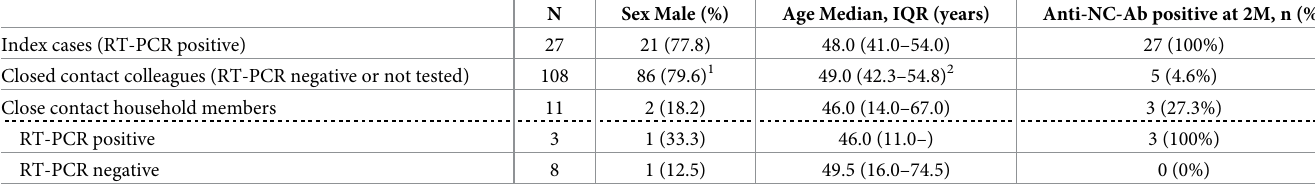
RT-PCR: reverse transcription polymerase chain reaction for severe acute respiratory syndrome coronavirus 2 (SARS-CoV-2); IQR: interquartile range; Anti-NC-Ab: antibody to the nucleocapsid of SARS-CoV-2; 2M: 2 to 3 months after the COVID-19 outbreak in the workplace; P -values between index cases versus close contacts are based on the Mann-Whitney U test or Fisher’s exact test; 1: P = 0.832; 2: P =